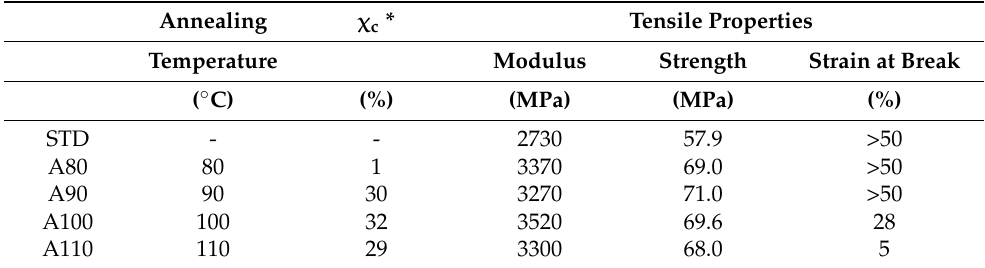
Table 1. Characteristics of PLA annealed at predetermined temperatures.